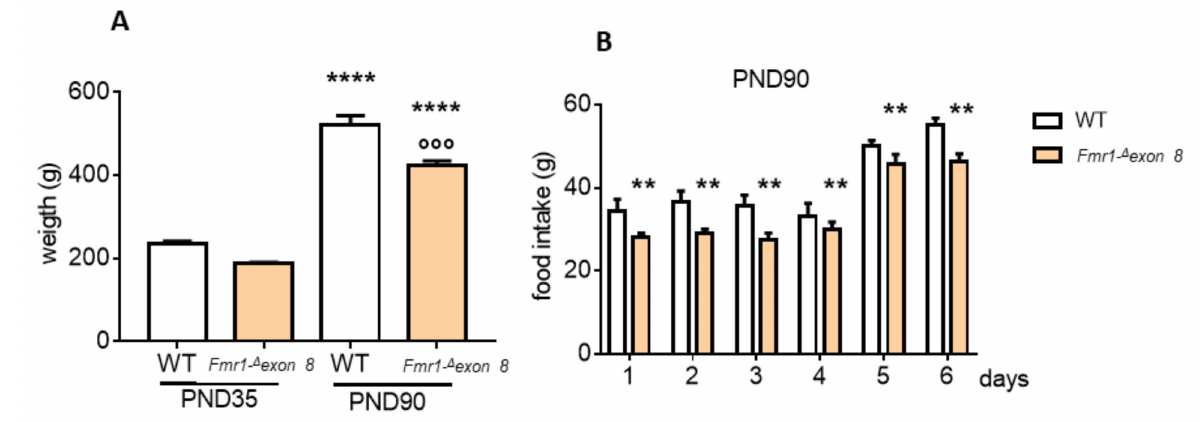
Figure 3. Body weight and food intake measurements of the Fmr1- ∆ exon 8 and WT male rats. ( A ) shows the weight of the Fmr1- ∆ exon 8 and WT adolescent (PND35) and adult (PND90) rats at the moment of euthanasia. ( B ) illustrates the grams of food intake of Fmr1- ∆ exon 8 and WT PND90 rats, measured during the last 6 days before euthanasia. Values represent mean ± SD obtained from 6 animals performed in duplicate. Statistical analysis was carried out by using the unpaired Student’s t -test. ◦◦◦ = p < 0.001 vs. WT PND90; **** = p < 0 .00001 vs. PND35; ** = p < 0.01 vs.